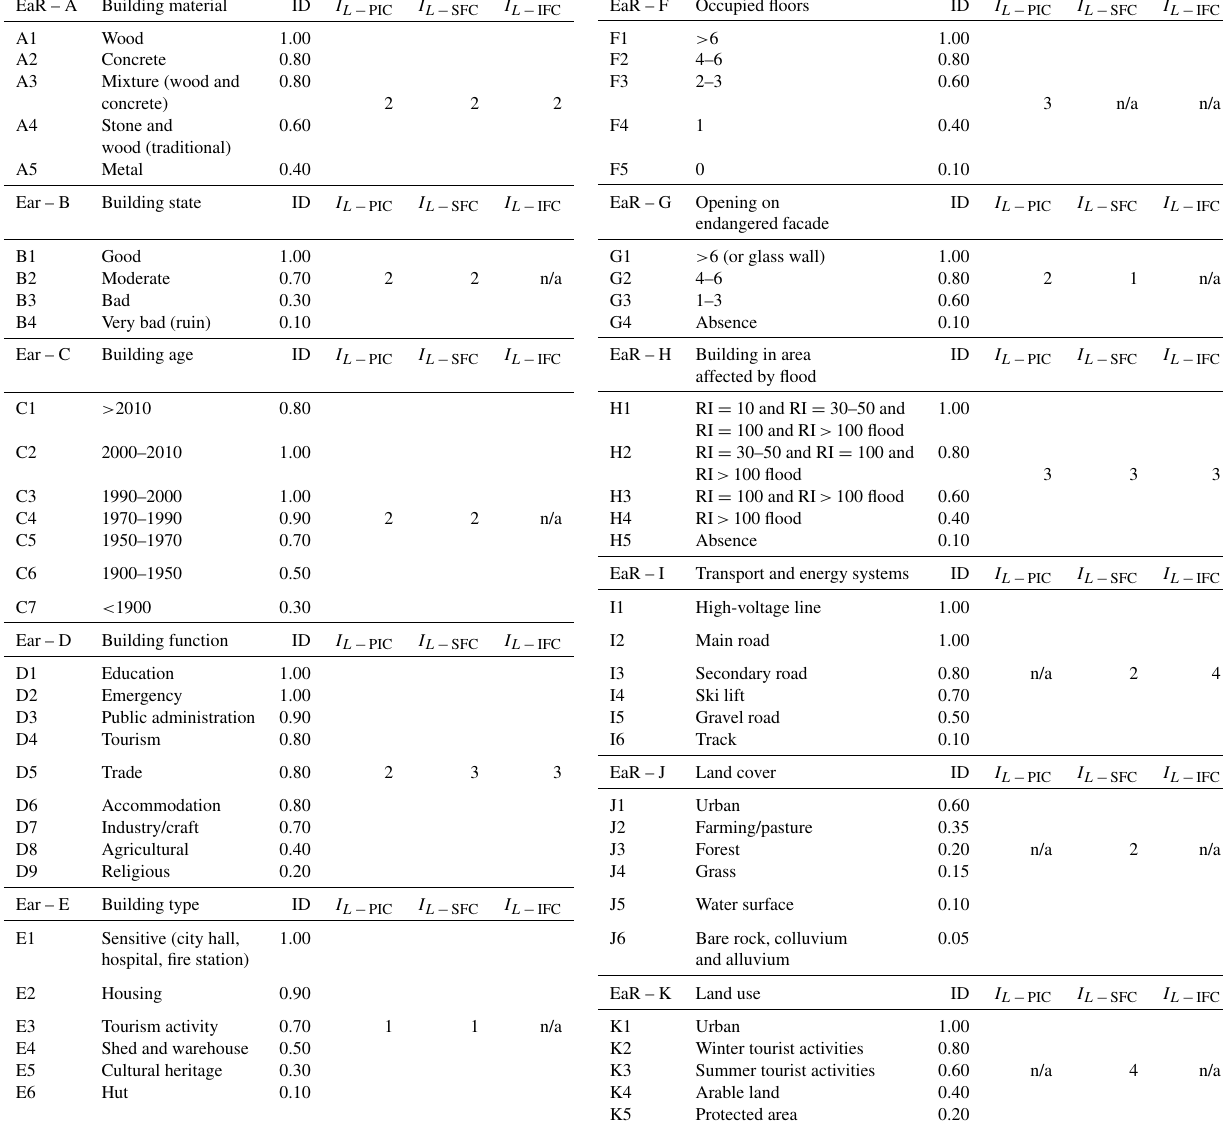
Table 1. Detail of weights assigned to the criteria used in PDI